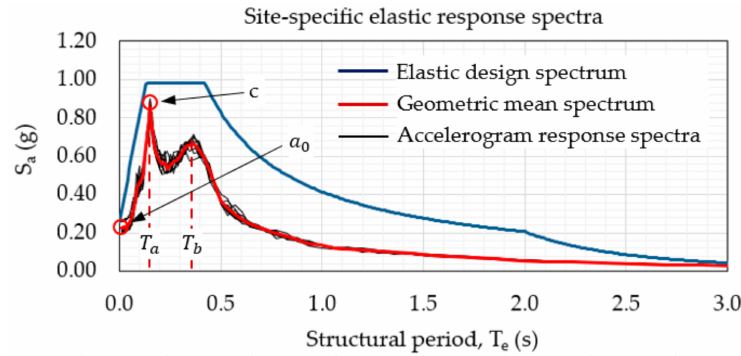
Figure 14. Graph of site-specific seismic elastic response spectra for Puebla,